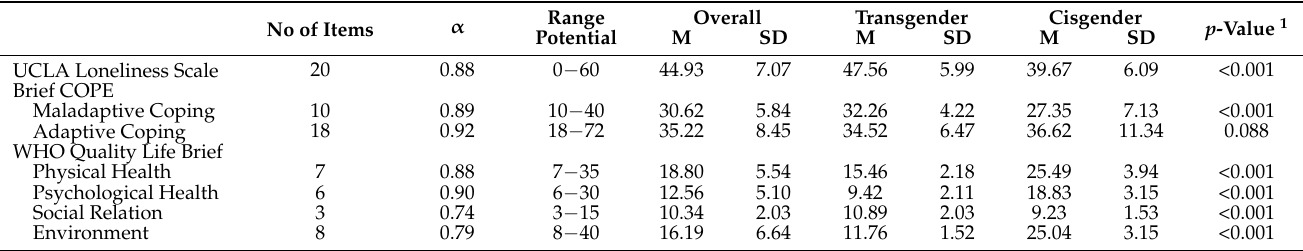
Table 2. Means and SD for overall sample, transgender sample ( N = 200), and cisgender sample ( N = 100) for major study variables. Cronbach values are for the overall